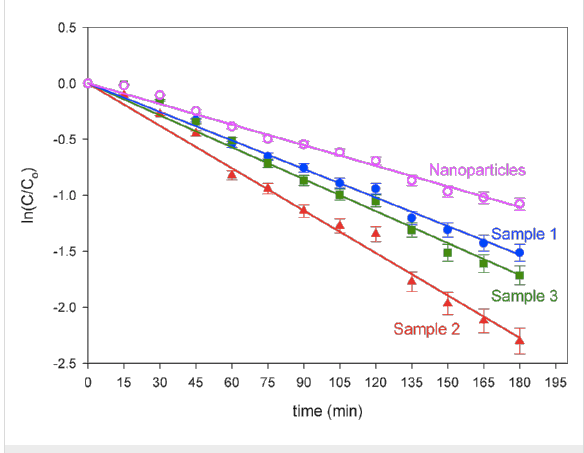
Figure 3: Degradation of methylene blue as a function of ln( C / C 0 ) versus the time of exposure to visible light on the ZnO nanoparticle film and the nanorods with different